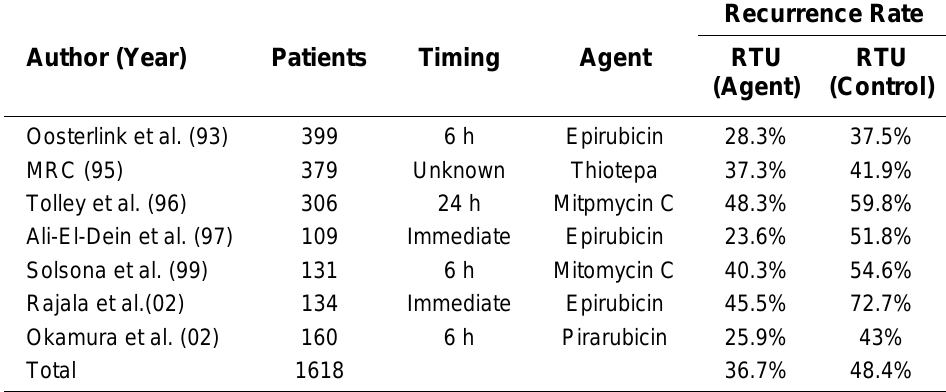
Randomized Trials Comparing Immediate Intravesical Chemotherapy and Control